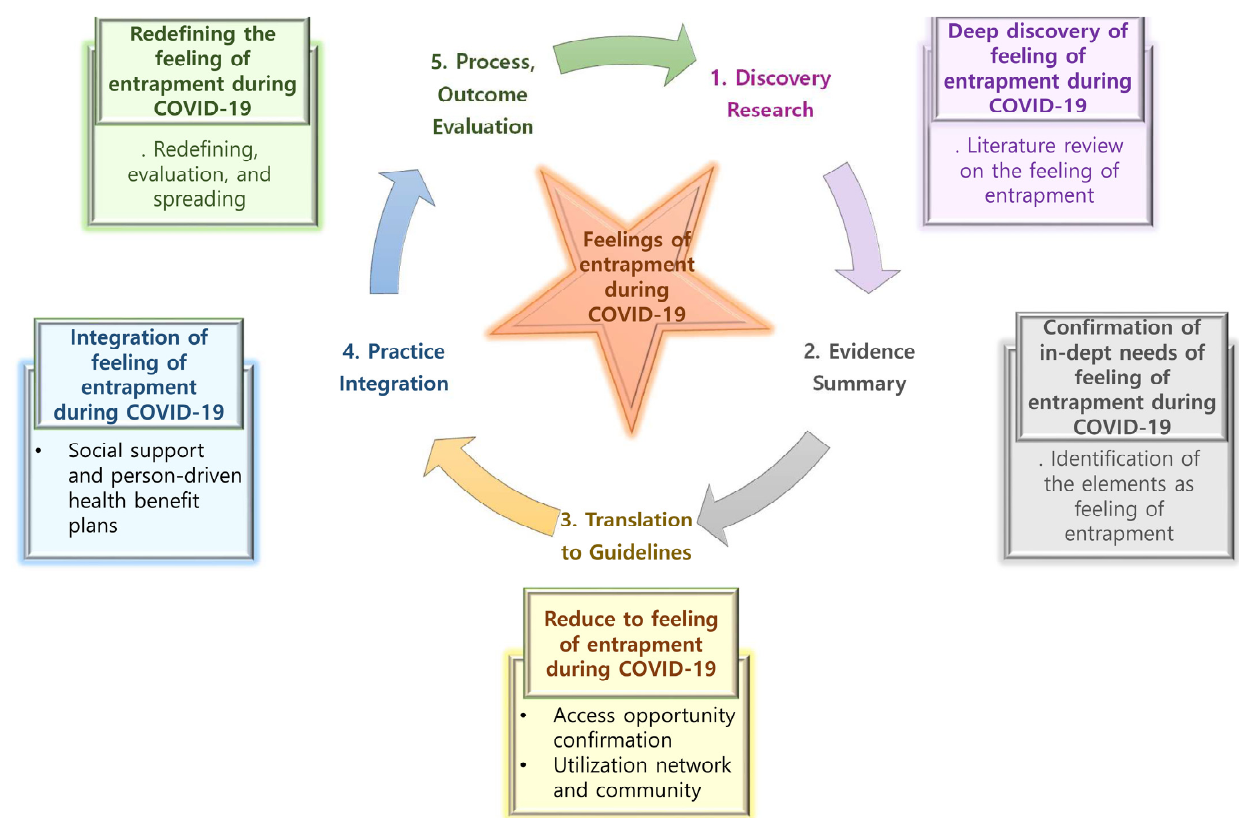
Figure 2. Conceptual framework of feelings of entrapment during the COVID-19 pandemic based on the ACE star model.